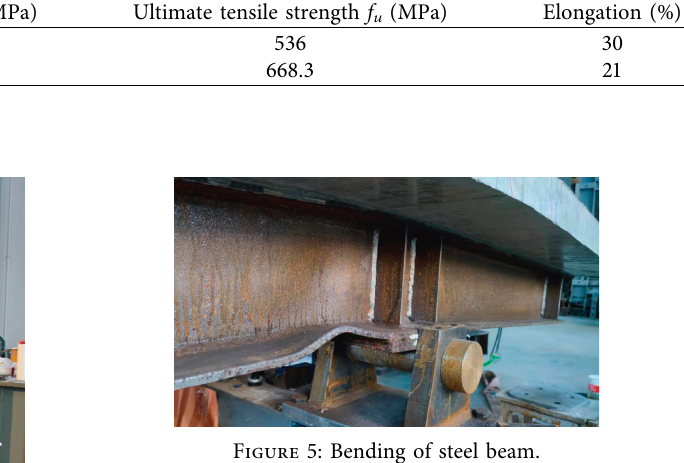
Figure 5: Bending of steel beam.